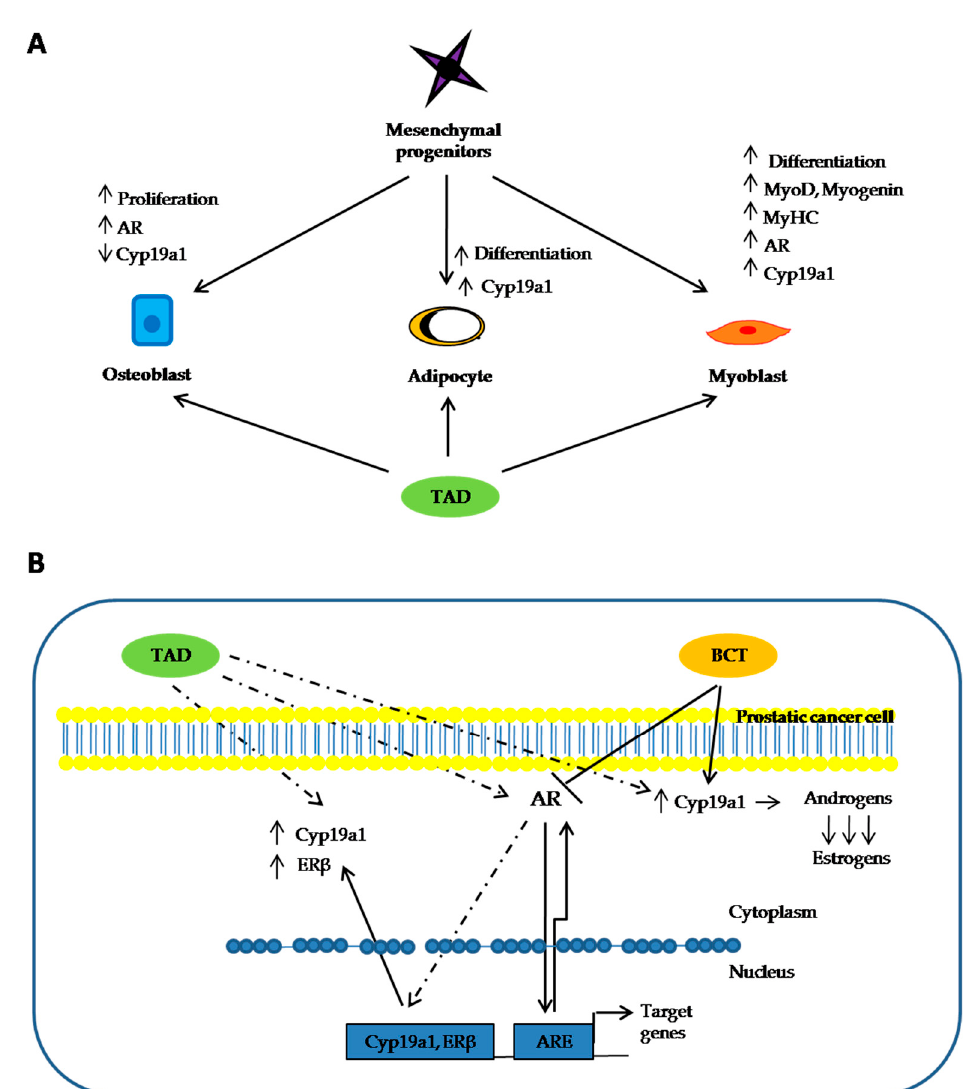
Figure 4. ( A ) Schematic representation of the effects of PDE5 inhibitor (PDE5i) tadalafil (TAD) on different cell lines on proliferation and differentiation. It is suggested that TAD may modulate the expression of molecules such as Cyp19a1 and the androgen receptor (AR). In particular in the osteoblastic cell, TAD leads to an increase of AR and a decrease of Cyp19a1 and it has been described an increase in cellular proliferation. In adipocyte cells TAD has a positive effect on Cyp19a1 expression. Moreover, in myoblasts, it has been reported to increase AR and Cyp19a1 proteins and of molecules involved in cell differentiation, such as MyoD, myogenin. ( B ) Molecular mechanism triggered by TAD in the prostate cancer cell line (dotted lines represent unexplained effects). Chronic exposure to TAD induced an increase in AR protein expression and an increase in gene and protein expression of ER β and Cyp19a1. We hypothesize that chronic exposure to BCT may induce loss of ER β due to induction of Cyp19a1, and cotreatment with TAD is able to block these effects.